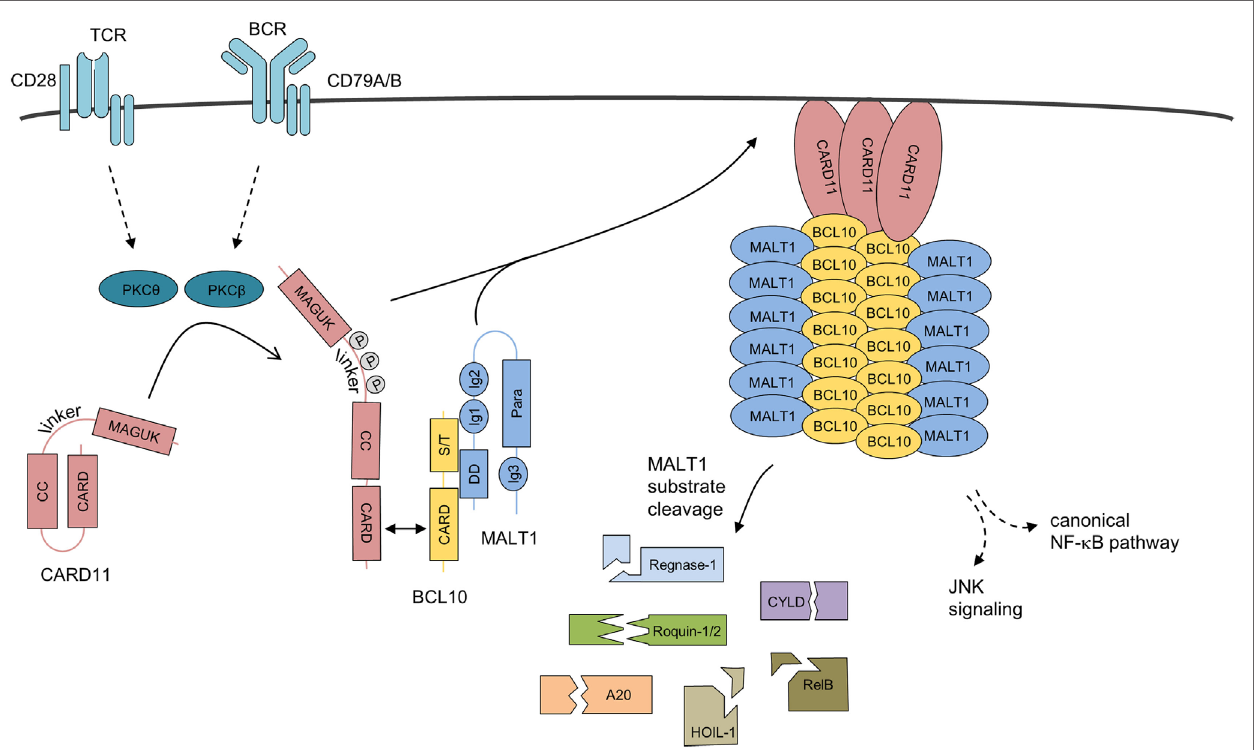
FiguRe 3 | Assembly mechanism of the higher-order CBM-1 complex. Upon antigen receptor ligation on lymphocytes, CARD11 is released from its inactive state by phosphorylation and initial homotypic CARD–CARD oligomerization. CARD11 clusters at the cell membrane, induce the recruitment of pre-assembled BCL10-MALT1 complexes, and serve as a molecular seed for the formation of BCL10 filaments. BCL10–MALT1 filaments provoke NF- κ B and JNK activation. In parallel, MALT1 protease is activated, which catalyzes cleavage of various cellular substrates. Abbreviations: CARD, caspase-recruitment domain; CC, coiled-coil; MAGUK, membrane-associated guanylate kinase; S/T, Ser/Thr-rich region; DD, death domain; Ig, immunoglobulin-like domain; Para, paracaspase domain; BCL10, B-cell lymphoma/leukemia 10; MALT, mucosa-associated lymphoid tissue.